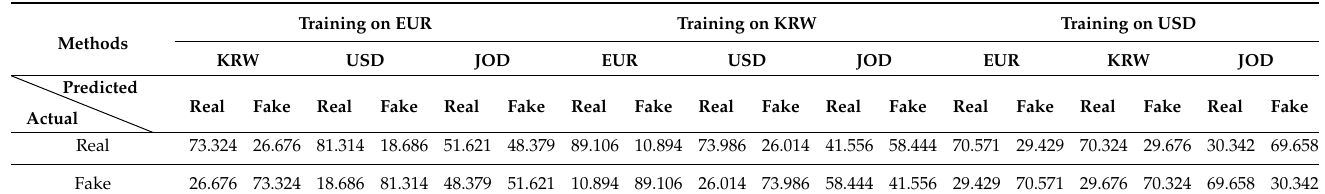
Table 10. Confusion matrices of experimental results of training on EUR, KRW, and USD, and testing on the other currency types using proposed fusion methods on two additional CNN classifiers. (Measure: average classification accuracy, unit: